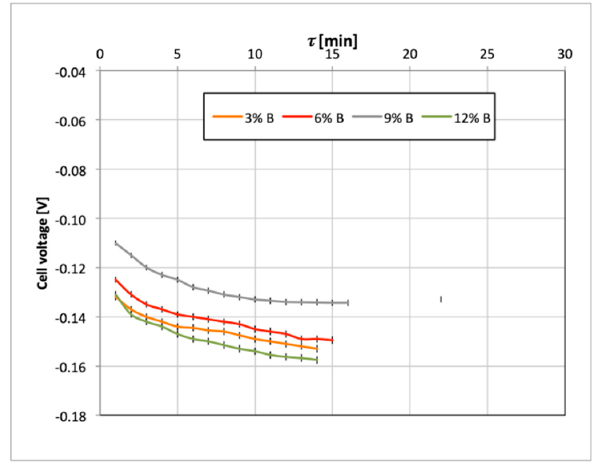
Figure 2. The electroless potential of electrodes with Cu–B catalyst which were oxidized for 1 h.